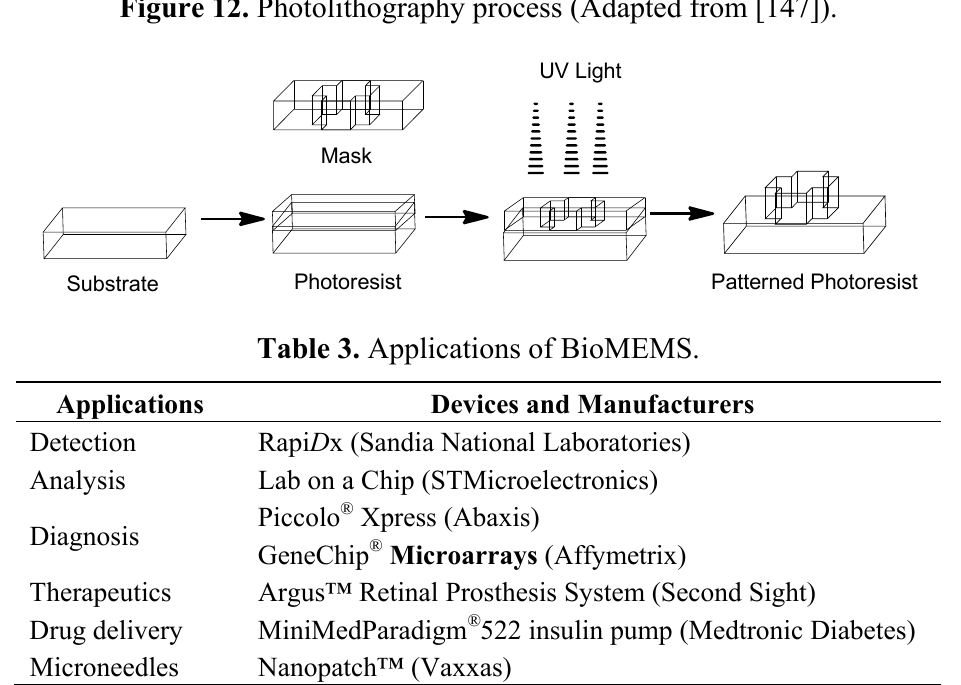
Figure 12. Photolithography process (Adapted from [147]).